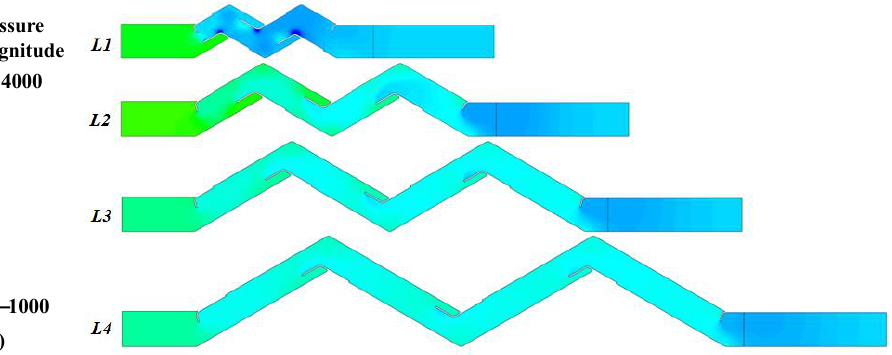
Figure 9. Pressure contour of demisters under inlet velocity U g = 12.00 m/s in different wavelengths.